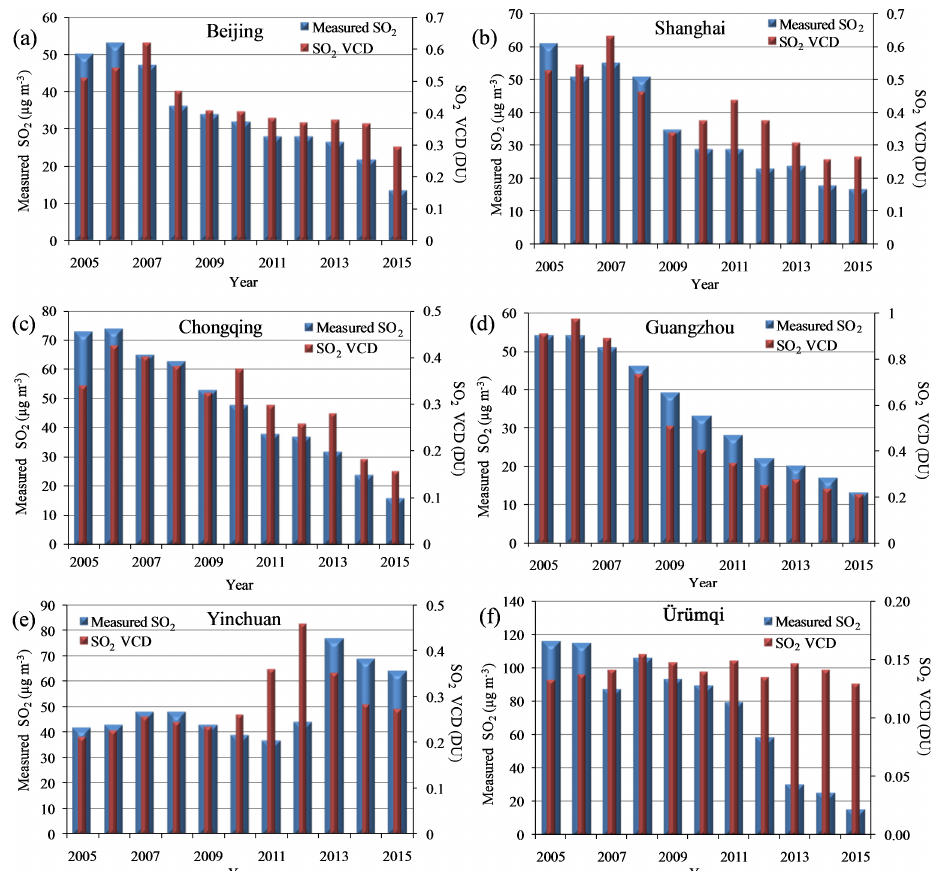
Figure 2. Annually averaged SO 2 VCD (DU), scaled on the right-hand-side y axis, and measured annual SO 2 air concentration (µgm − 3 ), scaled on the left-hand-side y axis, in Beijing, Shanghai, Chongqing, Guangzhou, Yinchuan, and